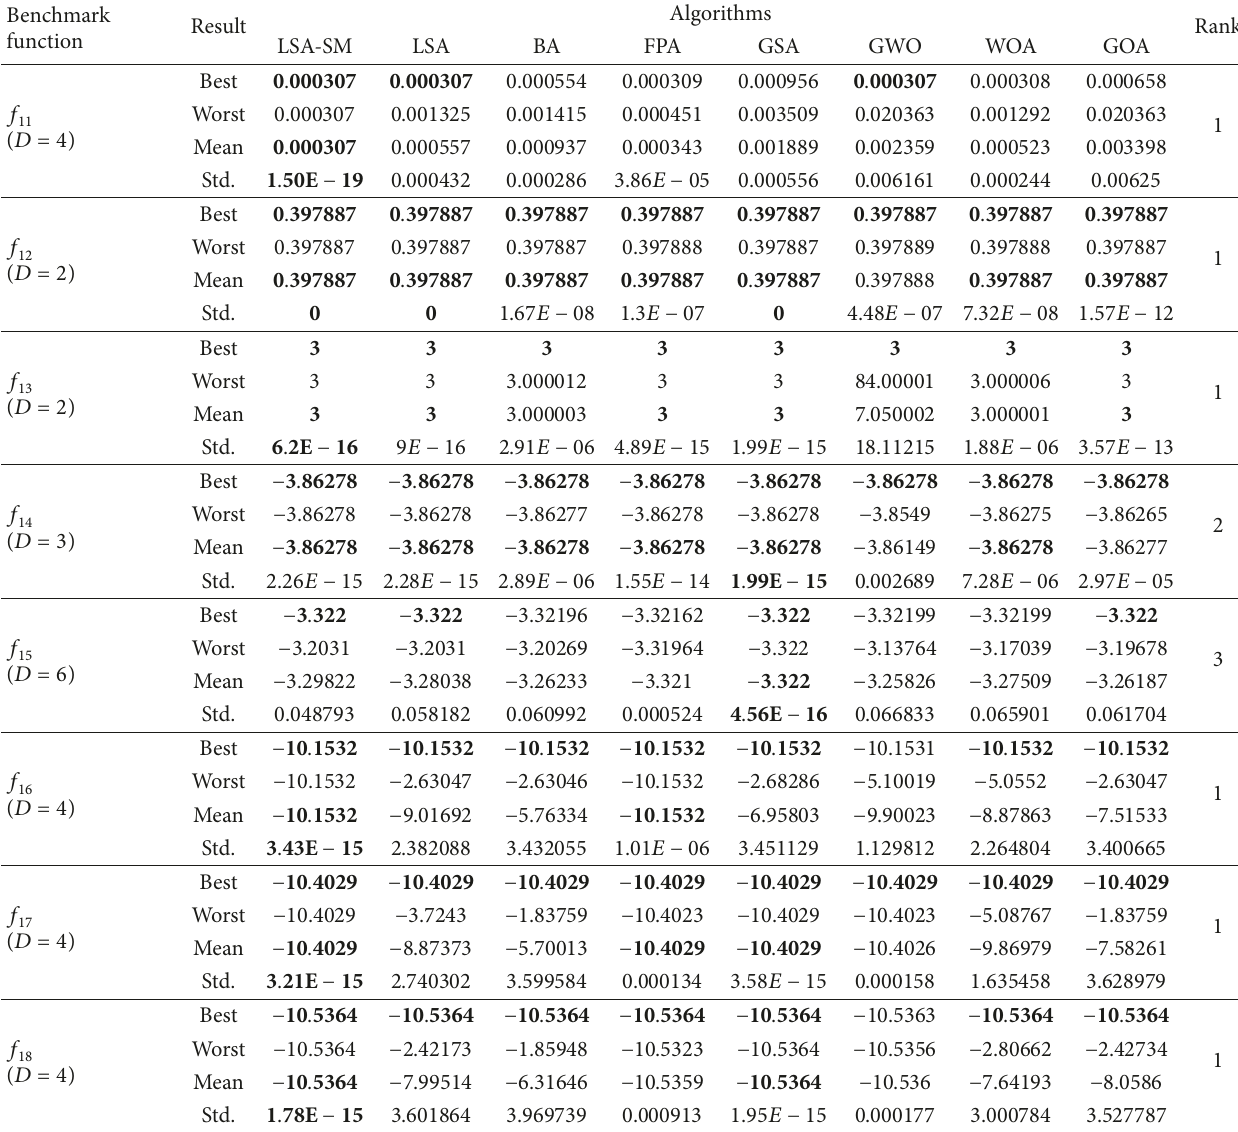
Table 6: Results of fixed-dimension multimodal benchmark